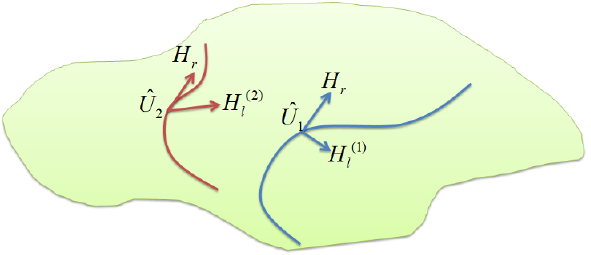
Figure 3 . The schematic (cid:12)gure to show that the left generator is not unique for a given right generator H r . The two left generators can be connected as: H (2) on the curves in the (cid:12)gure 3. A right generator H group. Depending on the positions ^ U Finally, eq. (4.6)